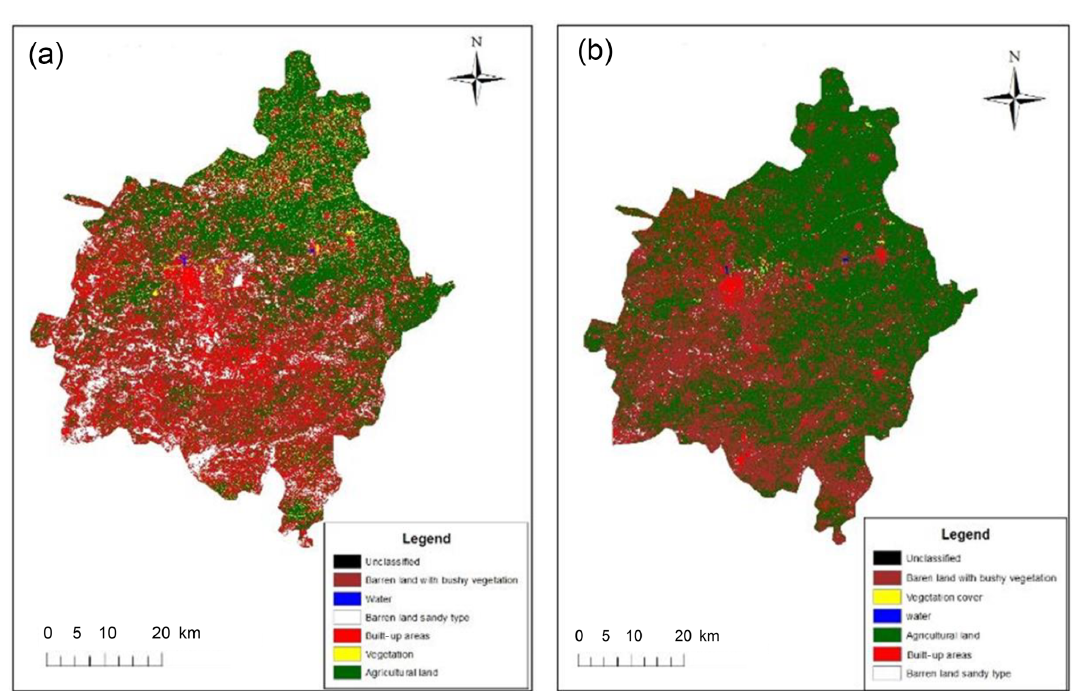
Figure 3. LULC map of Bathinda using unsupervised classification for (a) 2000 and (b) 2014.